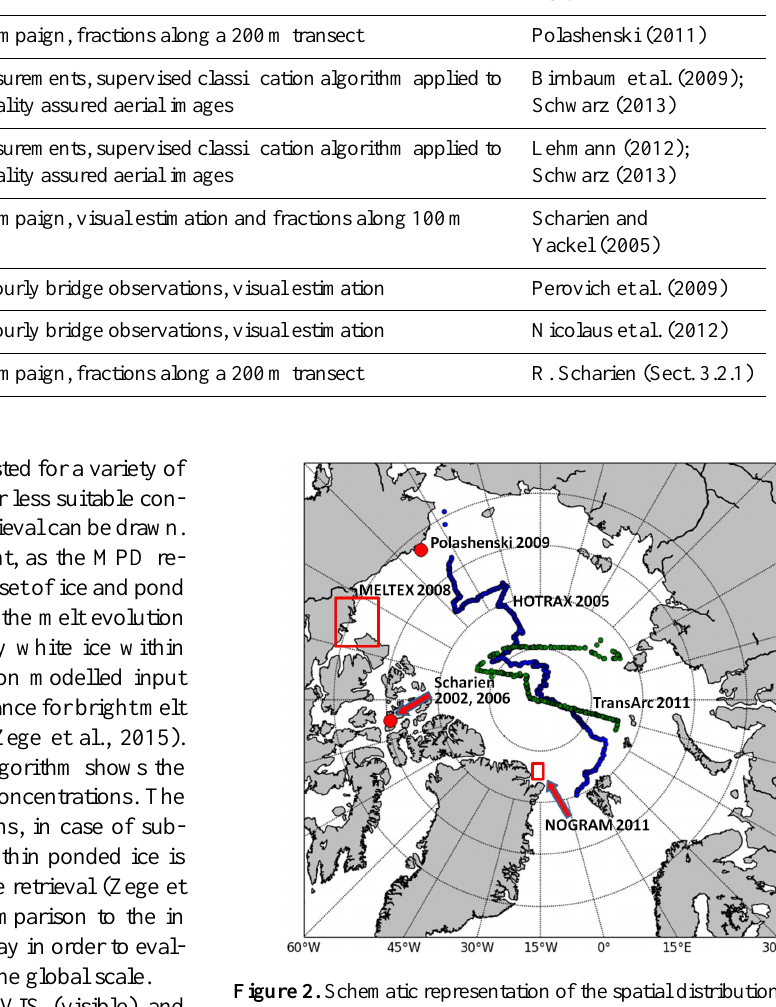
Table 1. Data sets used for validation of the MPD algorithm. Campaign and year